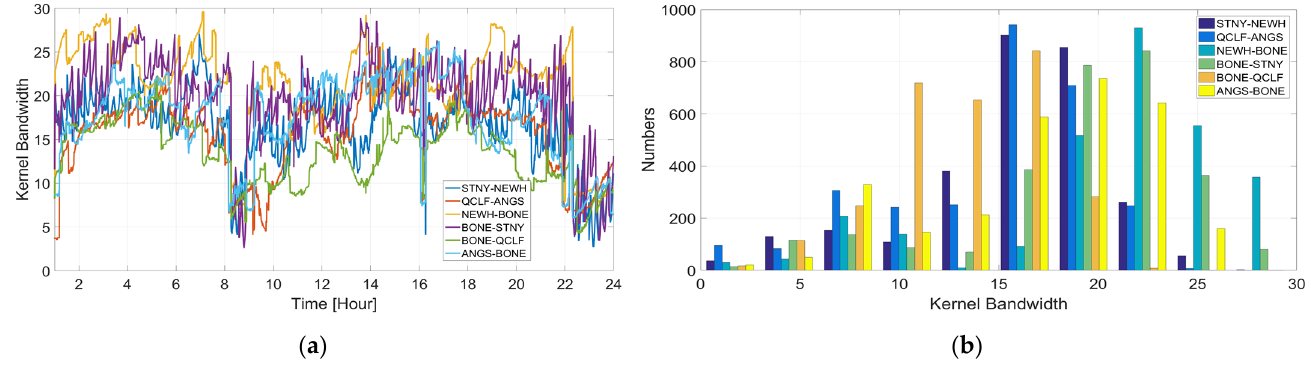
Figure 4. KBW time series and statistics for each baseline. ( a ) Time series for each baseline; ( b ) the statistics of KBW time series.